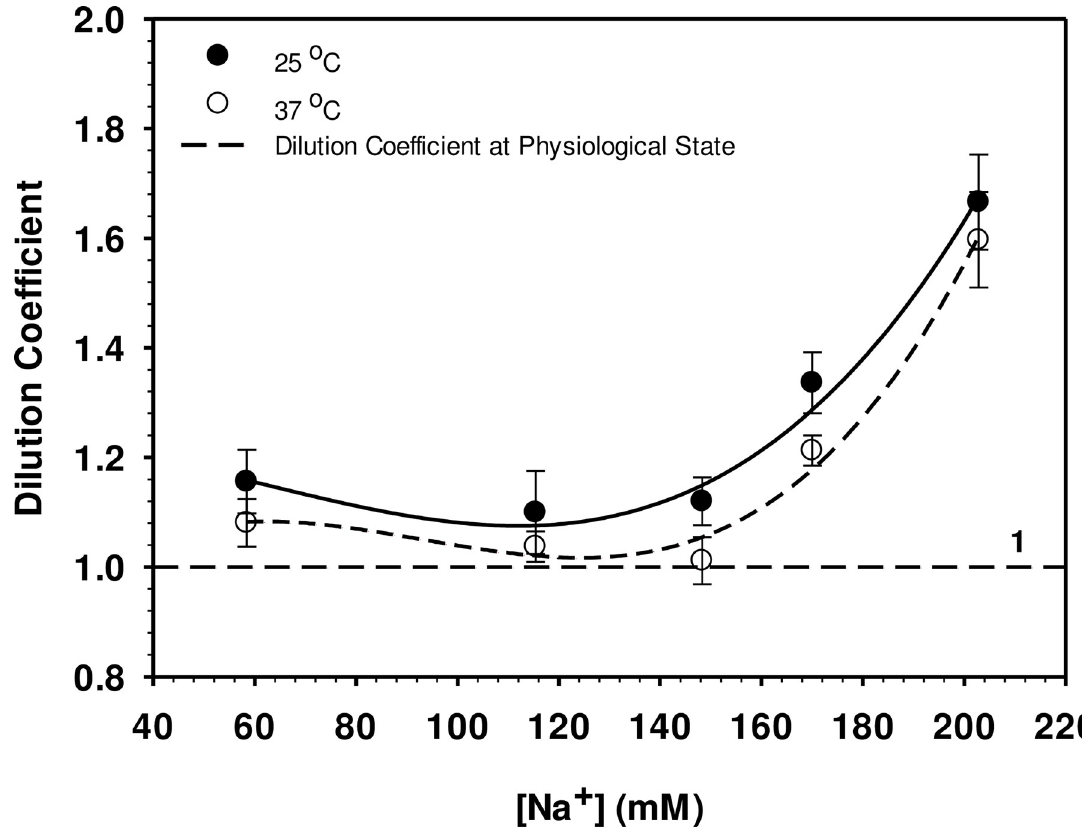
Fig 3. Dilution coefficient ( τ ) at 25˚C and 37˚C for 5 suspending media compared to that of a physiological value of τ = 1. Error bars are ± SE,means based on five replicates (5 separate individuals): the fitted lines are spline curves [35].The Tukey test interval for testing for significant (p < 0.05) differences between any two mean dilution coefficient values was τ = 0.278: τ at the two temperatures were not significantly different but at [Na + ] above the control concentration (148 mM) there were significant increases in τ at both